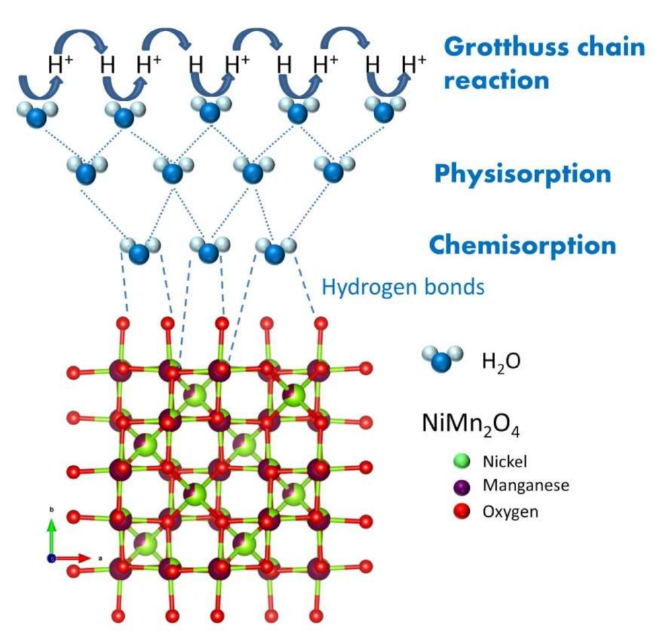
Figure 8. Humidity sensing mechanism of nickel manganite nanocrystalline fibers, NiMn 2 O 4 Fd 3 m cubic spinel structure drawn using VESTA